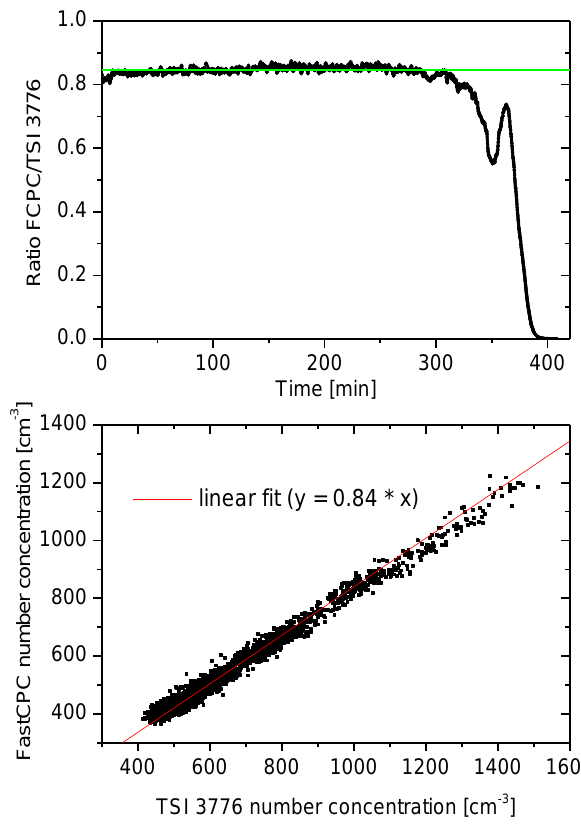
Fig. 5. Comparison of FCPC and TSI 3776 sampling room air from the laboratory. The upper plot displays the time series of the ra- tio number concentrations FCPC/TSI 3776. The horizontal green line displays the average value (0.85) during the first 250min. The lower plot shows the direct comparison of the number concentration measurement for the first 250min as well as a linear